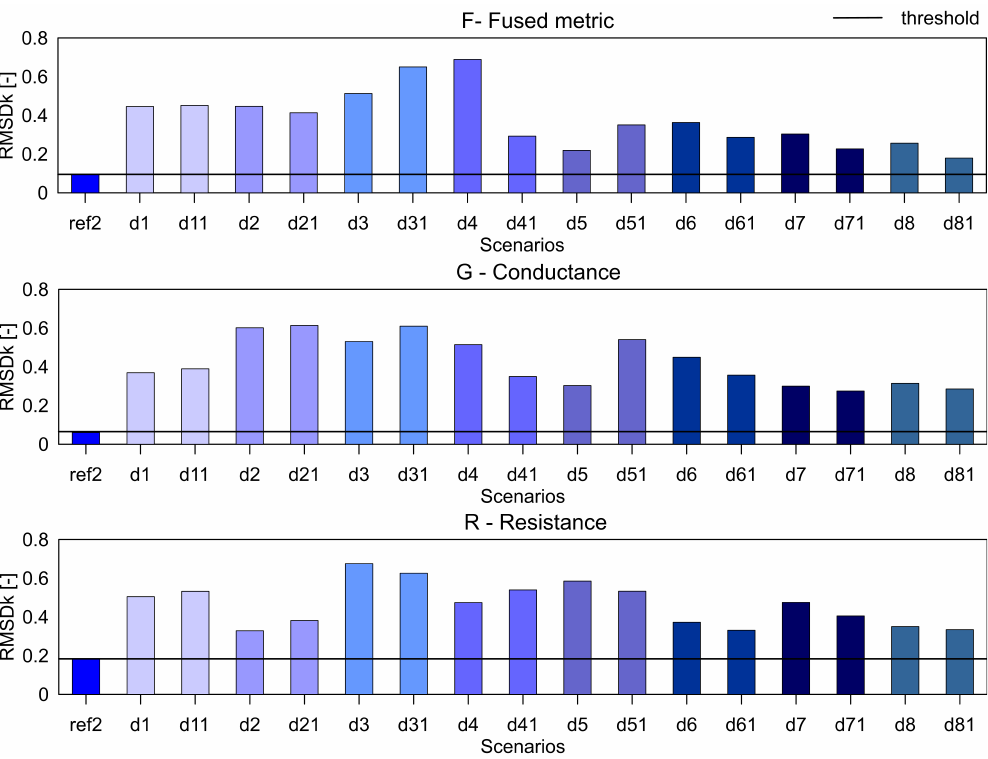
Figure 7. The RMSDk index for the variables F, G and R for aluminium plate.